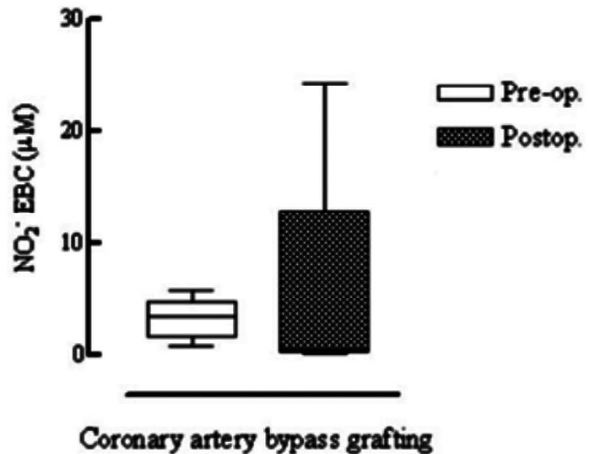
Fig 3 - Levels of NO 2- EBC in the pre-operative and postoperative